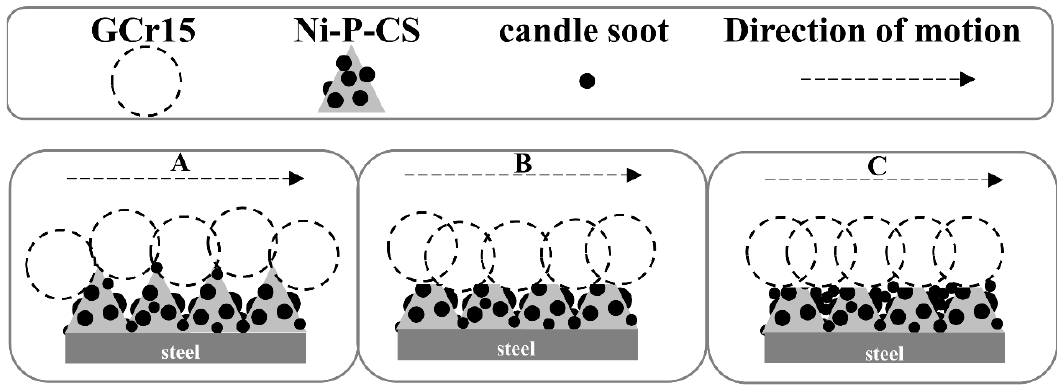
Figure 13. Friction mechanism of the Ni-P-CS composite coatings.